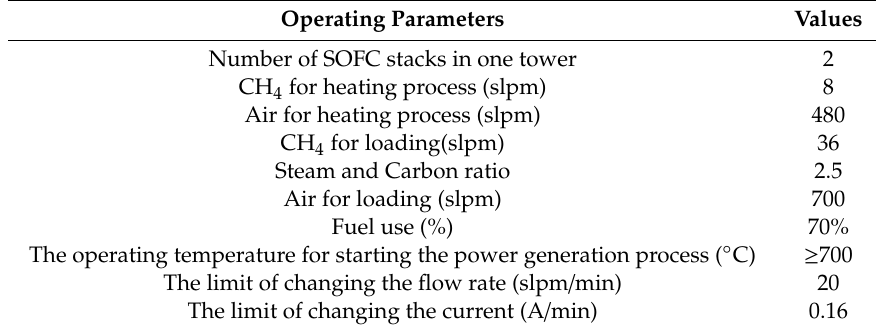
Table 4. Parameters of the simulation model for the manifold e ff ect